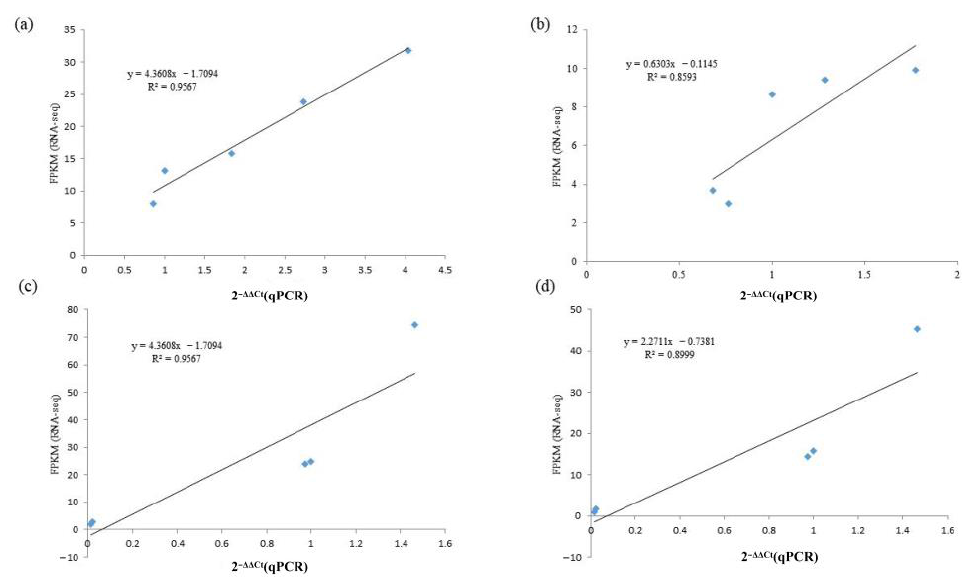
Figure 9. The linear relationship between RNA-seq and qRT-PCR data (( a – d ) are AGL12 , NCED1 , AGL24 and NADH , respectively).